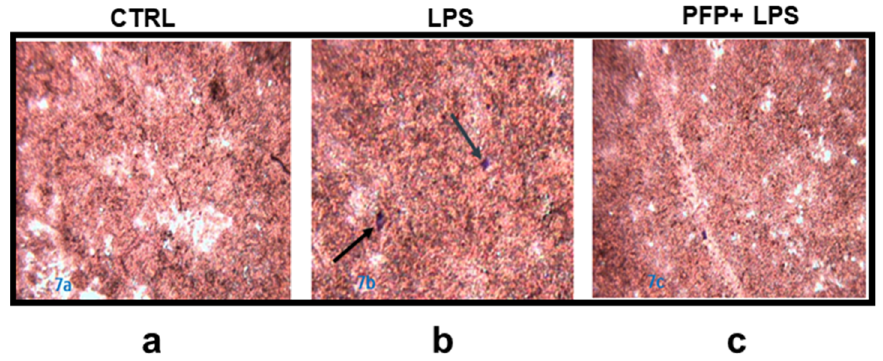
Figure 7. Microscope images of H&E staining of co-culture of THP-1 cells and HaCaT cells previously pre-treated with PFP (100 µg/mL) for 2 h and then stimulated with LPS for 24 h. ( a ) Untreated control HaCaT cells, ( b ) HaCaT cells stimulated with LPS, ( c ) HaCaT cells pre-treated with PFP and then stimulated with LPS.